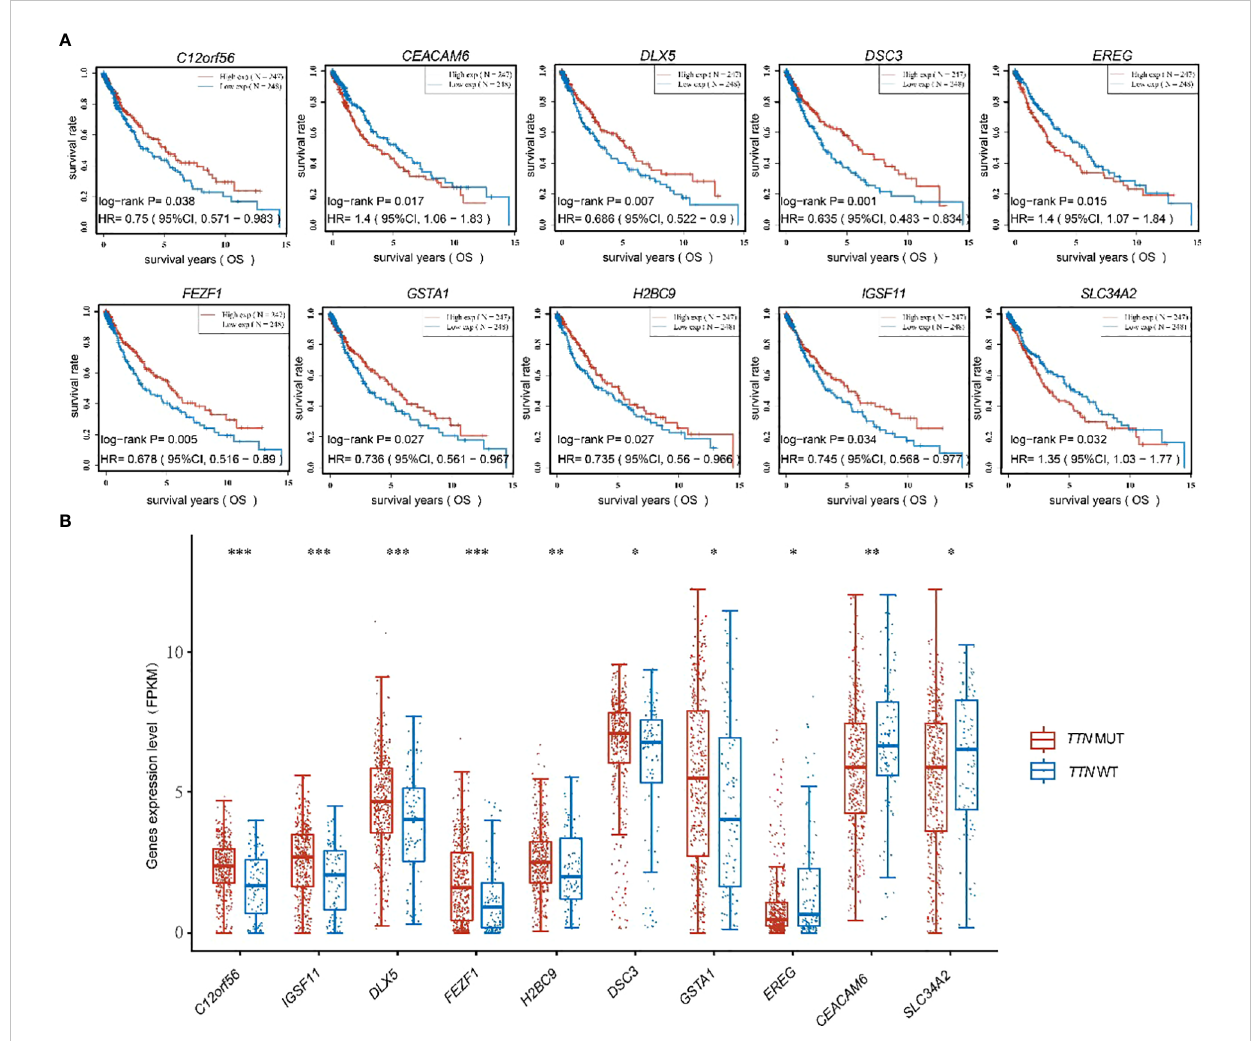
FIGURE 4 Figure 4 was shown to present the expression of ten bene fi cial factors and their impact on patient prognosis. (A) The high or low expression of the ten bene fi cial factors ( C12orf56, DLX5, DSC3, FEZF1, GSTA1, H2BC9, IGSF11, EREG, CEACAM6, SLC34A2 ) was demonstrated to have an impact on the prognosis of lung squamous cell carcinoma patients. (B) The expression of the ten bene fi cial factors ( C12orf56, DLX5, DSC3, FEZF1, GSTA1, H2BC9, IGSF11, EREG, CEACAM6, SLC34A2 ) in patients with TTN mutations and wild-type TTN patients was shown to be presented. t test was used for comparison between groups, with * indicating p<0.05, ** indicating p<0.01, and *** indicating